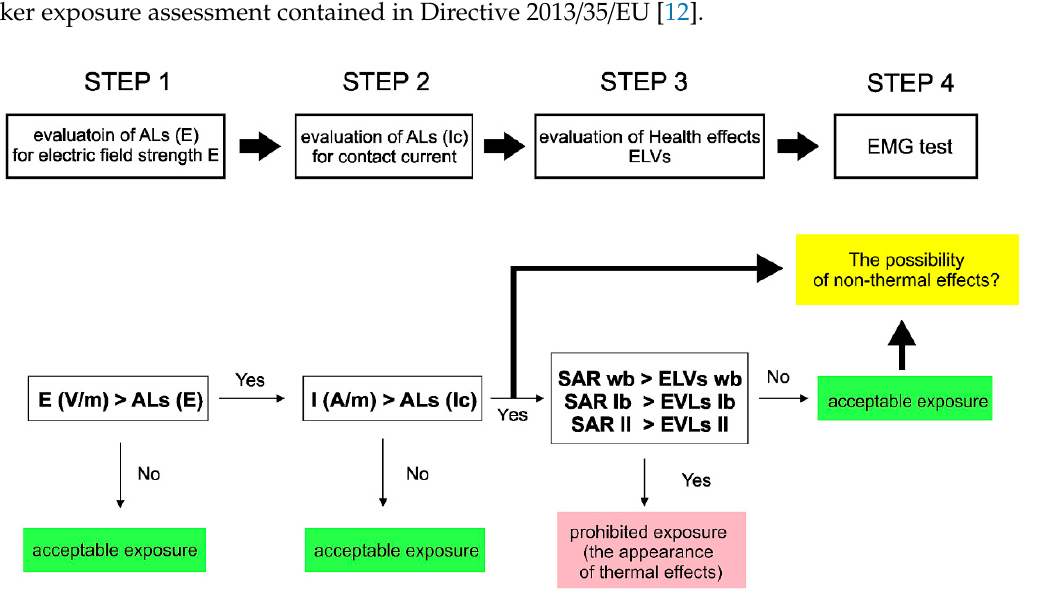
Figure1. TheflowchartoftheEMFexposureassessmentalgorithm(ALs—actionlevels, ELVs—exposure Figure 1. The flowchart of the EMF exposure assessment algorithm (ALs—action levels, ELVs— limit values, EMG—electromyography, SAR—specific absorption exposure limit values, EMG—electromyography, SAR—specific absorption rate).